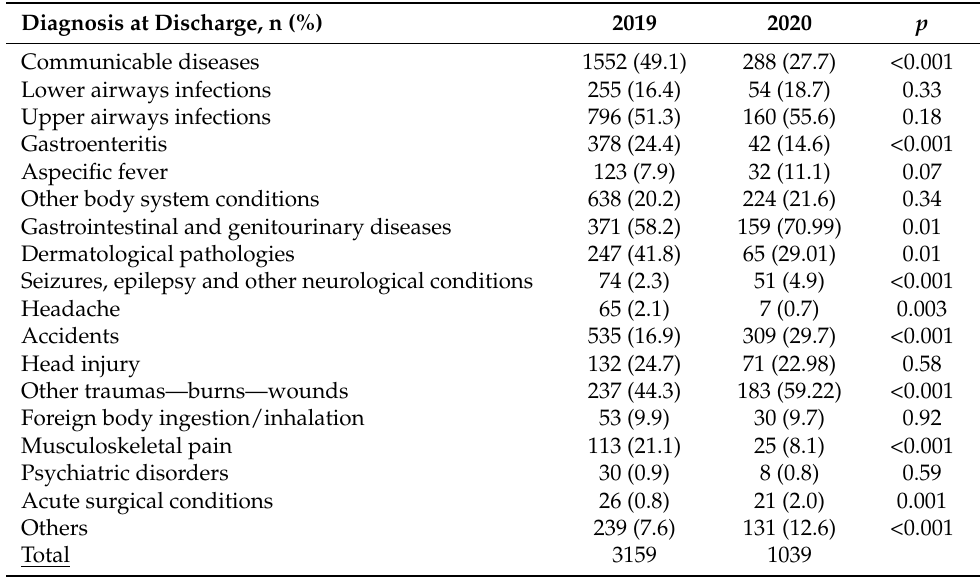
Table 3. Pediatric emergency department diagnosis at discharge in March–April 2019 (non-COVID- 19) compared with the same period in 2020